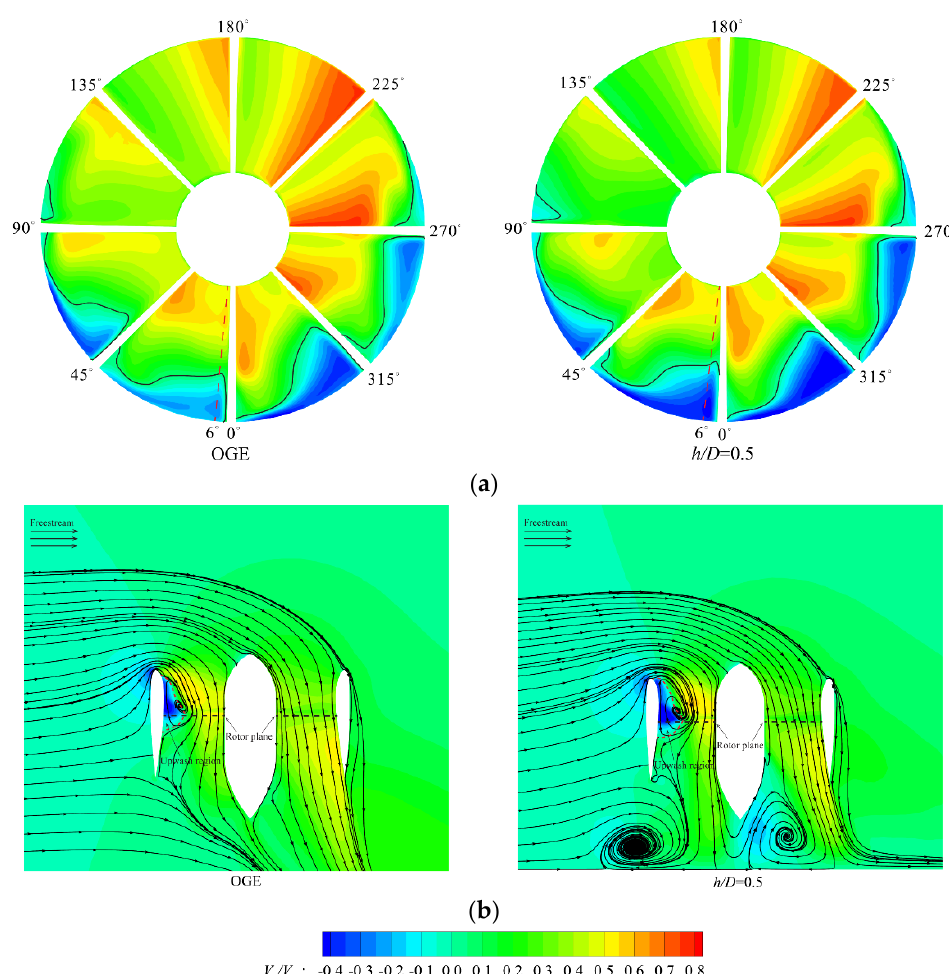
Figure 26. Axial velocity contour and streamlines on cross sections at J = 0.5, α = 90°: ( a ) cross section at ξ/c d = 0.425; ( b ) cross section at Ψ = 6°.